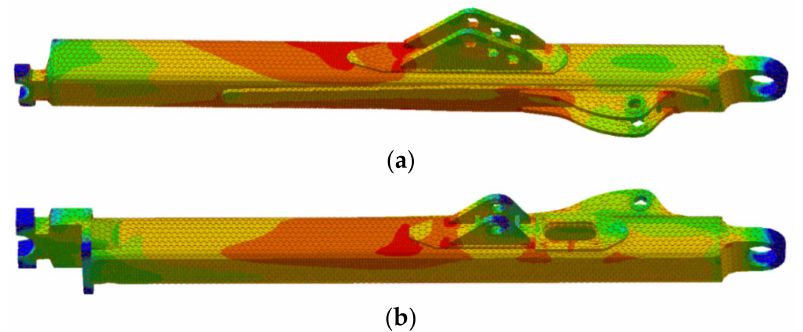
Figure 11. Life contour and damage distribution: ( a ) left push arm; ( b ) right push arm.